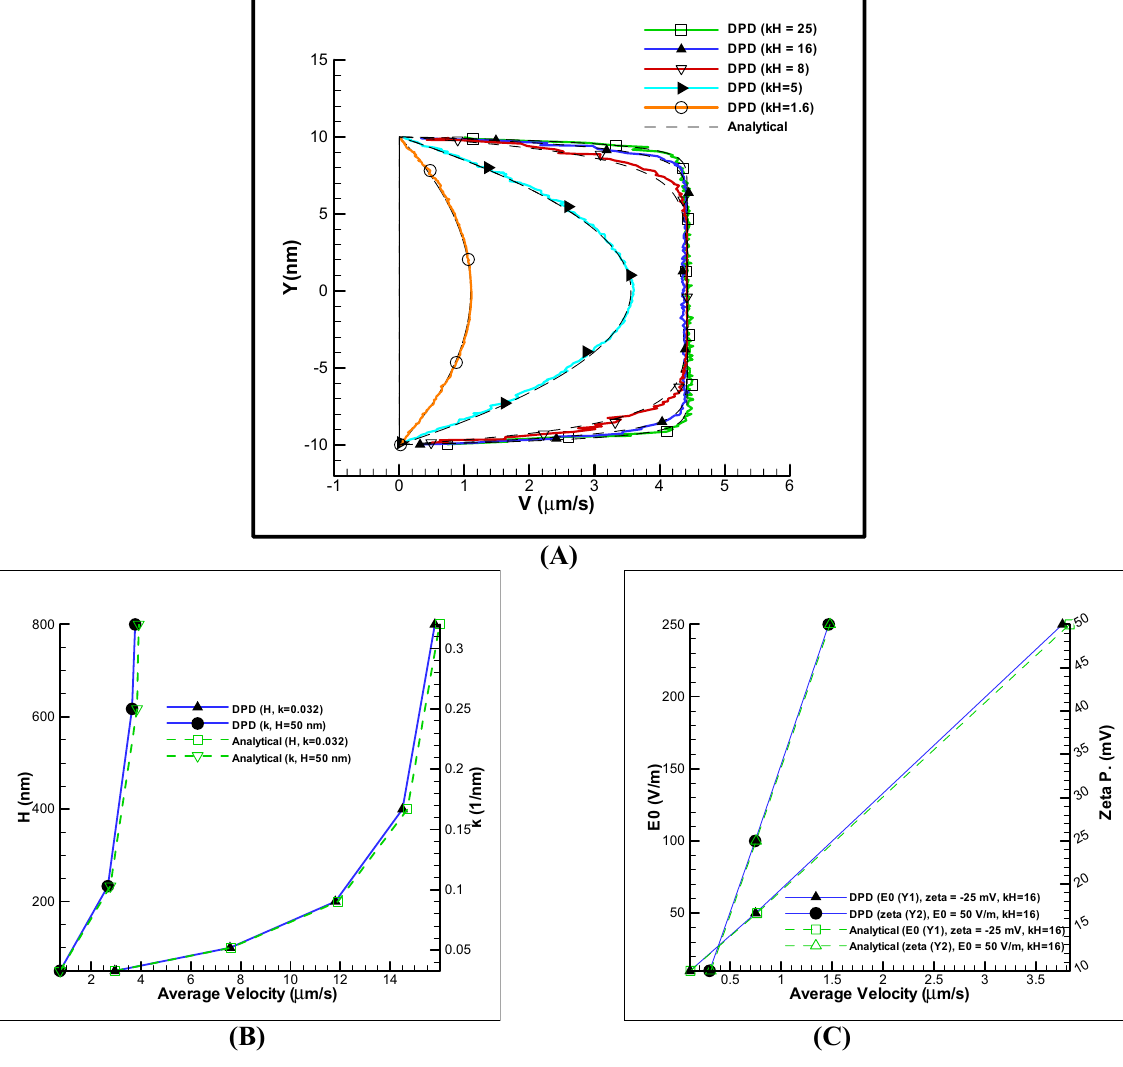
Figure 2. Validation of EOF-DPD results using analytical results. Comparison of DPD method and analytical solution: velocity profiles in different kH parameters ( A ) for E0 = 250 V/m, zeta potential − 25 mV and average velocity influenced from different reverse of EDL (k) and channel height, E0 = 250 V/m, ψ 0 =− 25 mV ( B ) and different electric fields and zeta potentials, kH = 16 ( C ).